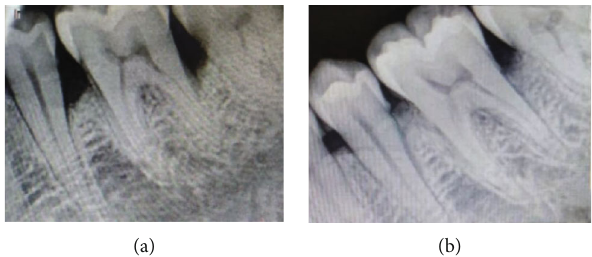
Figure 5: Radiographic image: (a) preoperative and (b)